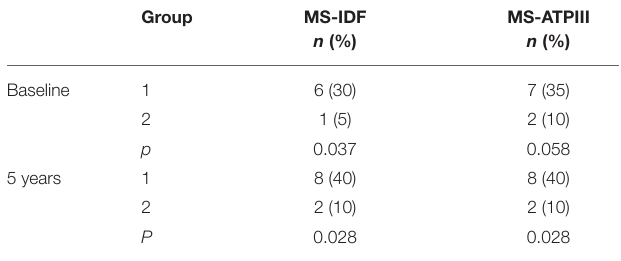
TABLE 8 | Differences in prevalence of MS at study entry and after 5-year follow-up between patients (group 1) and controls (group